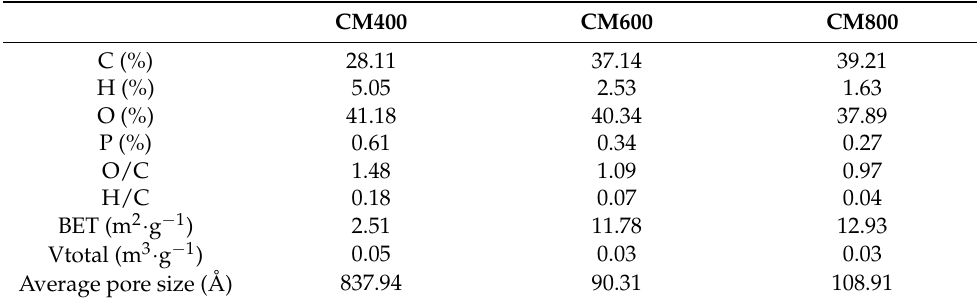
Table 1. Basic elemental composition, specific surface area, and pore structure of